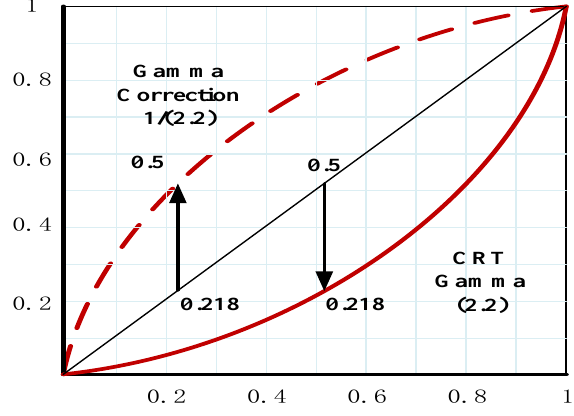
Figure 2. Gamma-correction diagram.